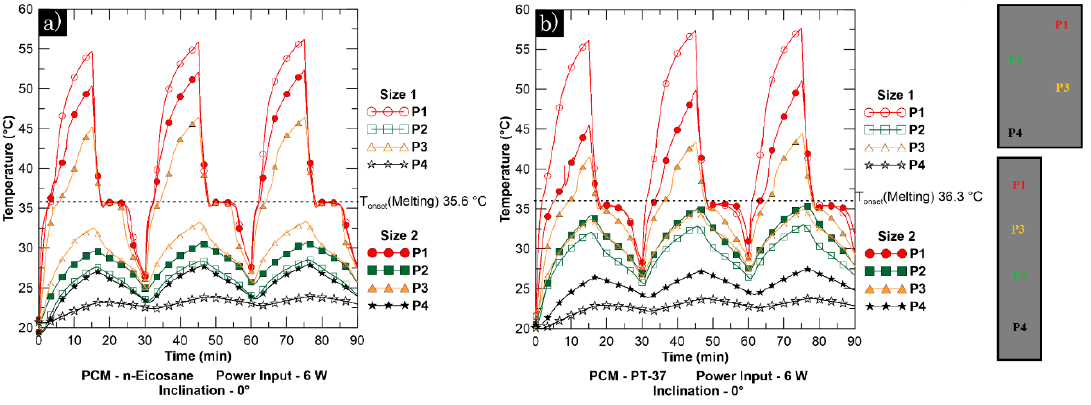
Figure 6. Influence of PCM TES size on PCM melting at 6 W power input and 0° inclination: ( a ) n-eicosane and ( b ) PT-37.